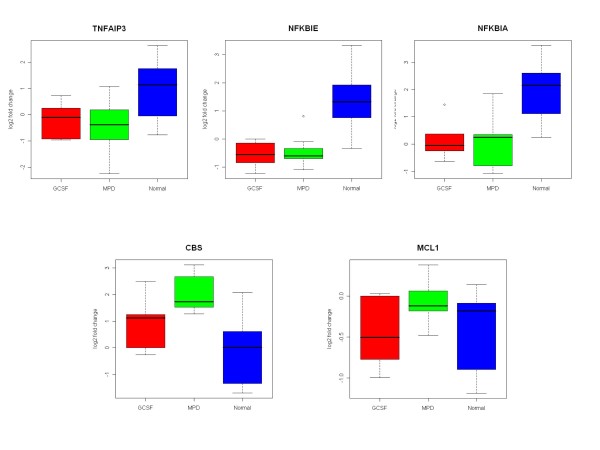
Analysis of differentially expressed MPD neutrophil genes by quantitative real time PCR (RT-PCR). The expression of five genes NFKBIA, NFKBIE, TNFAIP3, MCL1 and CBS in MPD neutrophils was analyzed by qRT-PCR. The expression of NFKBIA, NFKBIE, and TNFAIP3 were down-regulated in MPD and G-CSF-mobilized neutrophils. The expression of CBS was significantly increased in MPD neutrophils. The expression of MCL1 was also increased in MPD neutrophils but the difference was not significant. The results of analysis by qRT-PCR and gene expression profiling were similar.